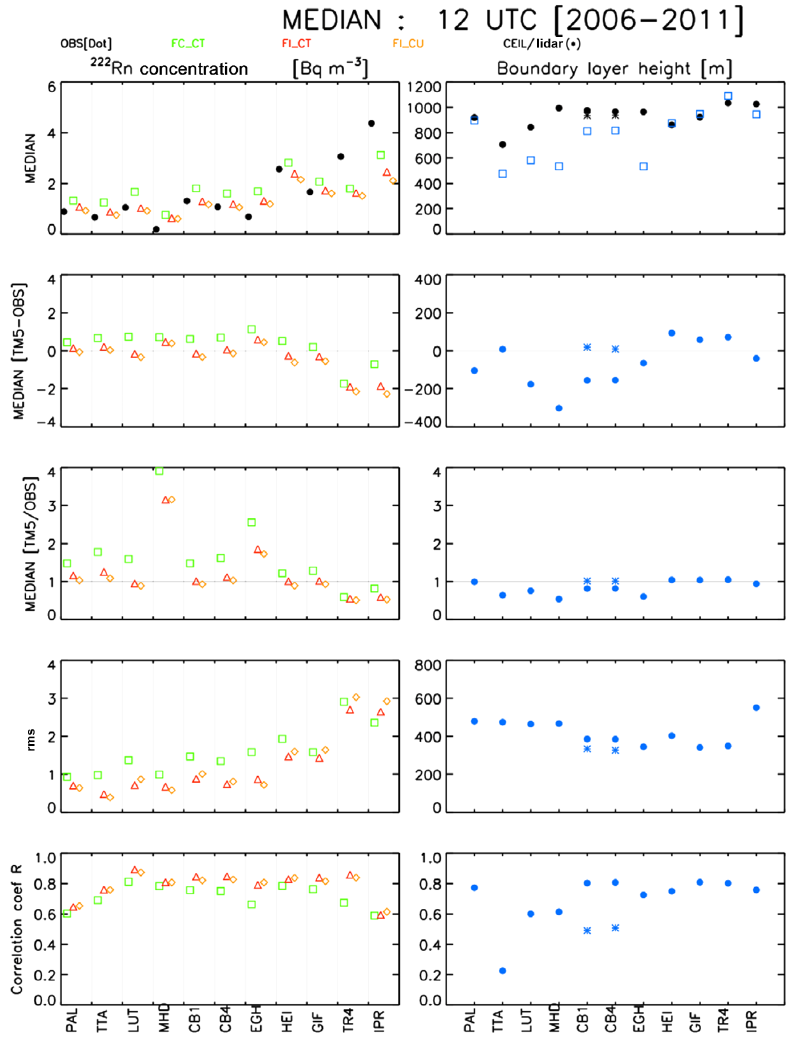
Figure 8. Left: statistics of observed vs. simulated 222 Rn activity concentrations for the different stations (12:00UTC). Right: statistics of observed (IGRA ( • ) and ceilometer (CEIL)/lidar ( ∗ )) vs. simulated boundary layer heights (TM5_INGOS_IGRA) (12:00UTC). The acronyms of the stations ( x axis) are given in Table 1. For the median and rms values, the units are given on the top of the two